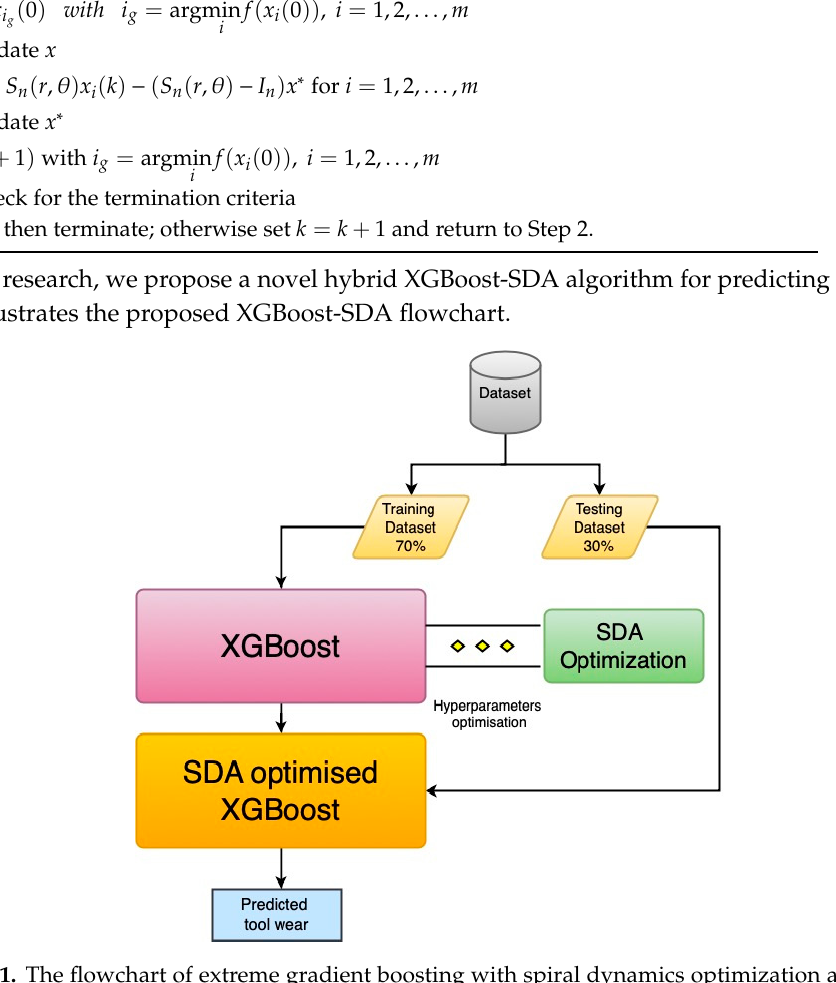
Figure 1. The flowchart of extreme gradient boosting with spiral dynamics optimization algorithm (XGBoost-SDA).